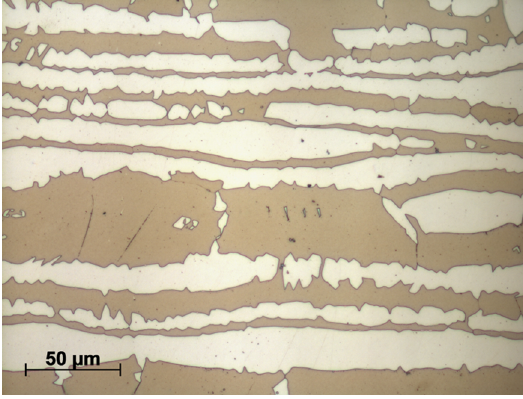
Figure 1. Microstructure of the as received material. Optical Microscopy. Modified Behara Etchant.